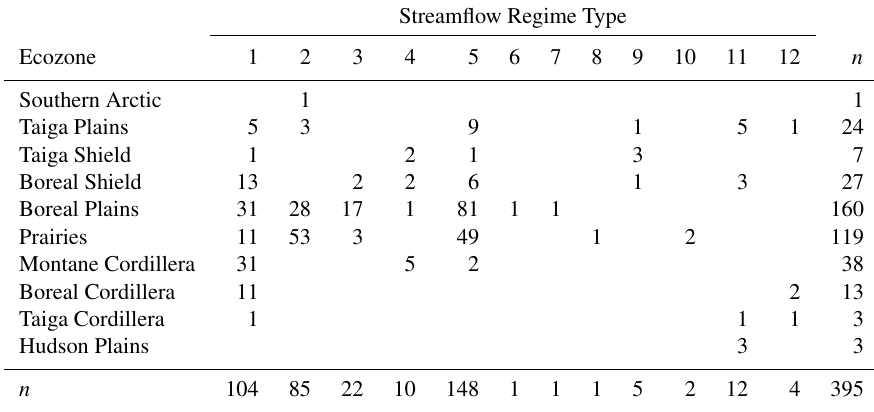
Table 3. Streamflow Regime Type classification in relation to the ecozone in which the station is